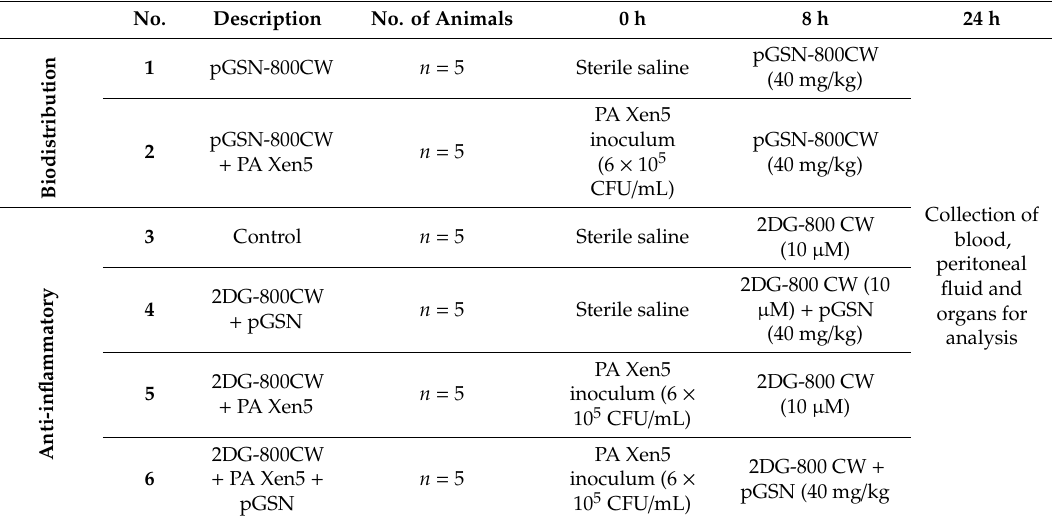
Table 1. Groups of animals used in the